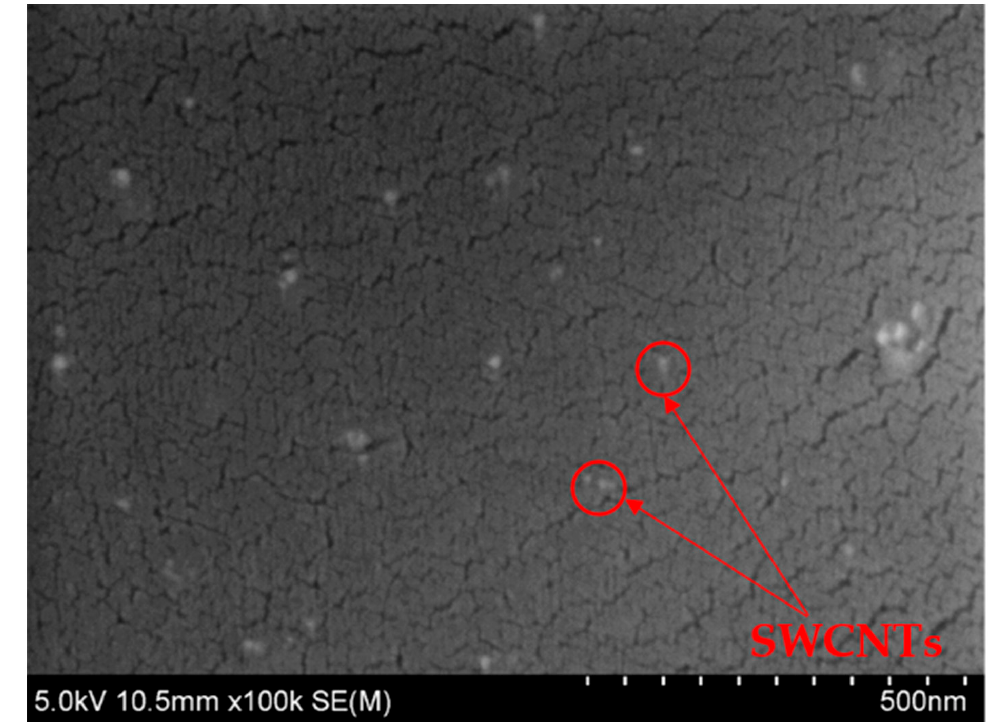
Figure 4. Microstructure of CFRP with 0.02 wt.% of SWCNTs.